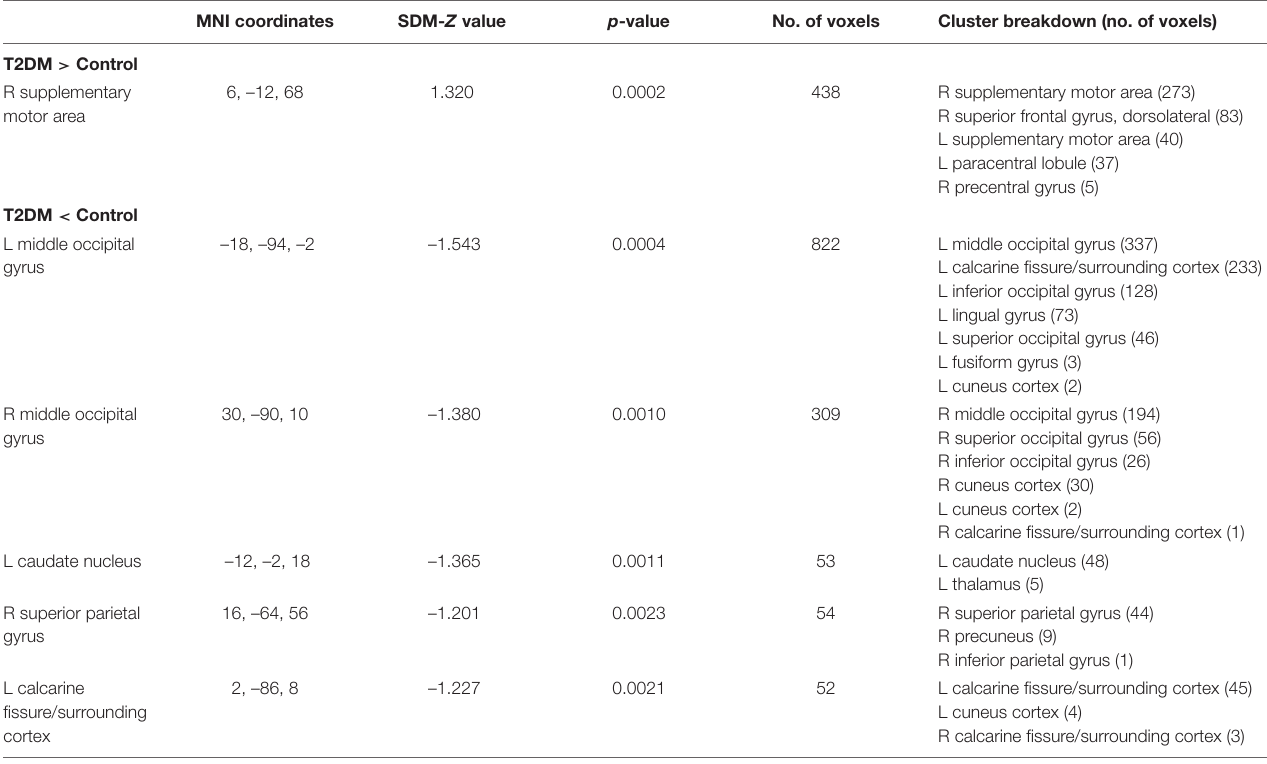
TABLE 4 | Differences in regional cerebral blood flow alterations between patients with T2DM and healthy